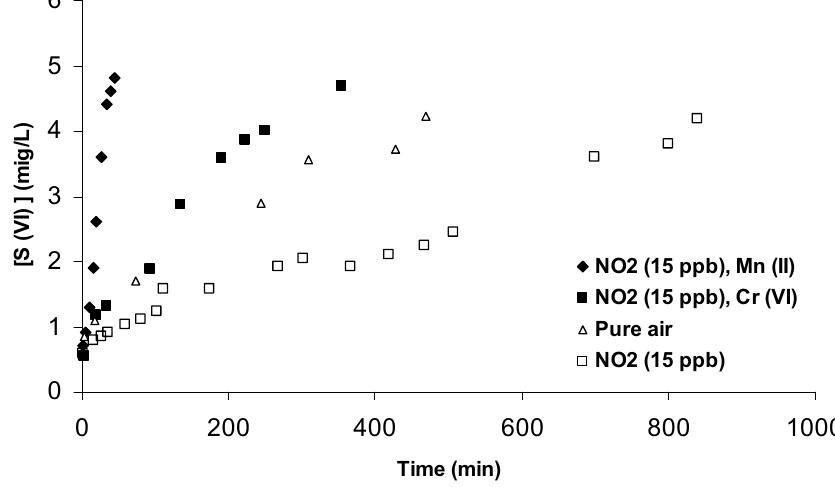
Fig. 4a – Time dependence of [S(VI)] for S(IV) oxidation, [S(IV)] ◦ = 8 mg/L, pH = 5.2, T = 22 ◦